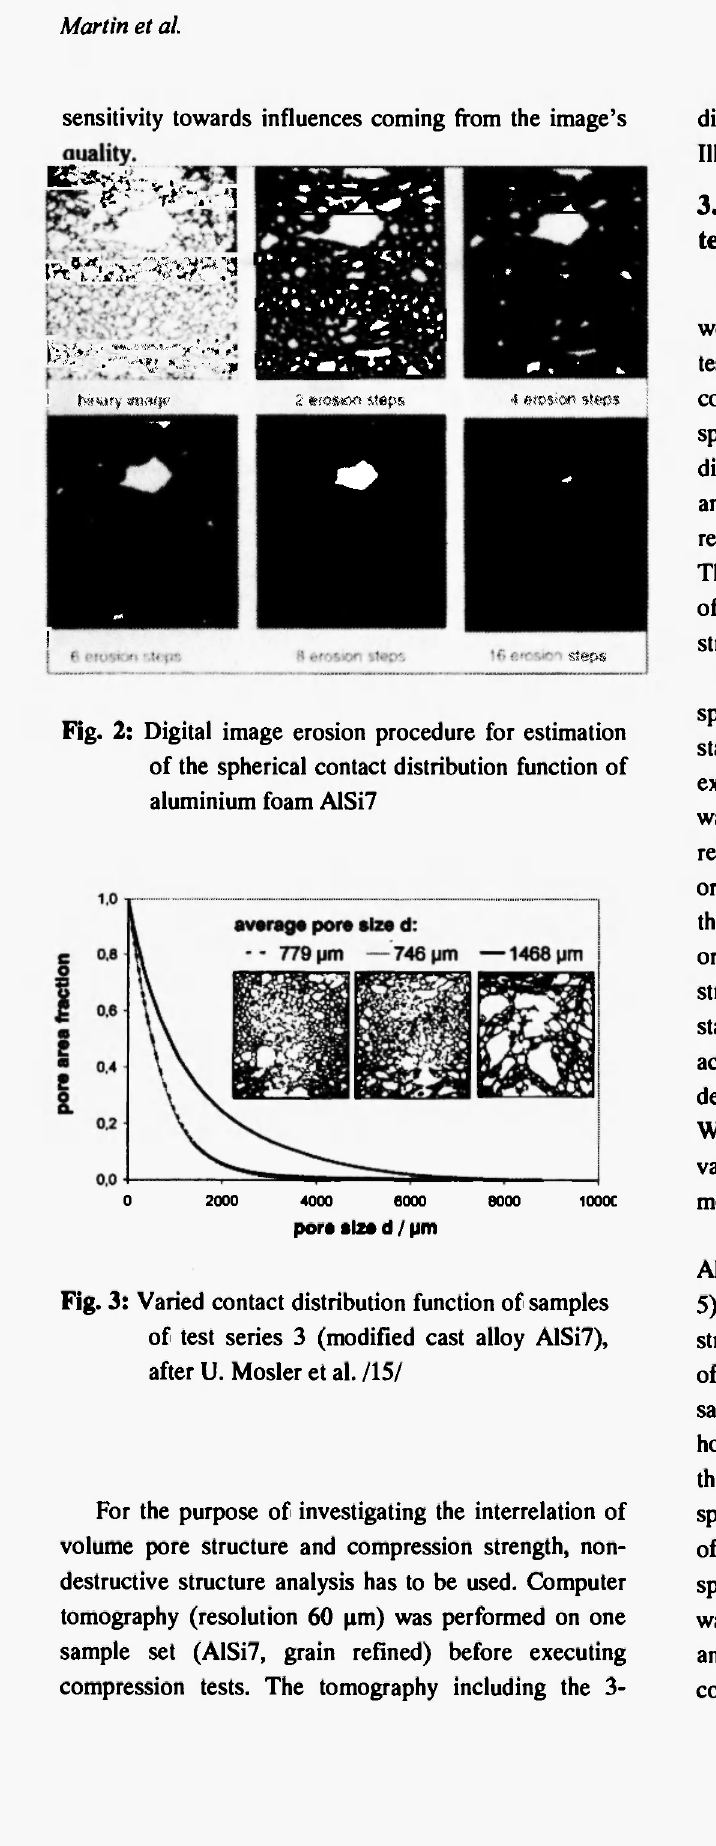
For the purpose of investigating the interrelation of volume pore structure and compression strength, non- destructive structure analysis has to be used. Computer tomography (resolution 60 μηι) was performed on one sample set (AlSi7, grain refined) before executing compression tests. The tomography including the